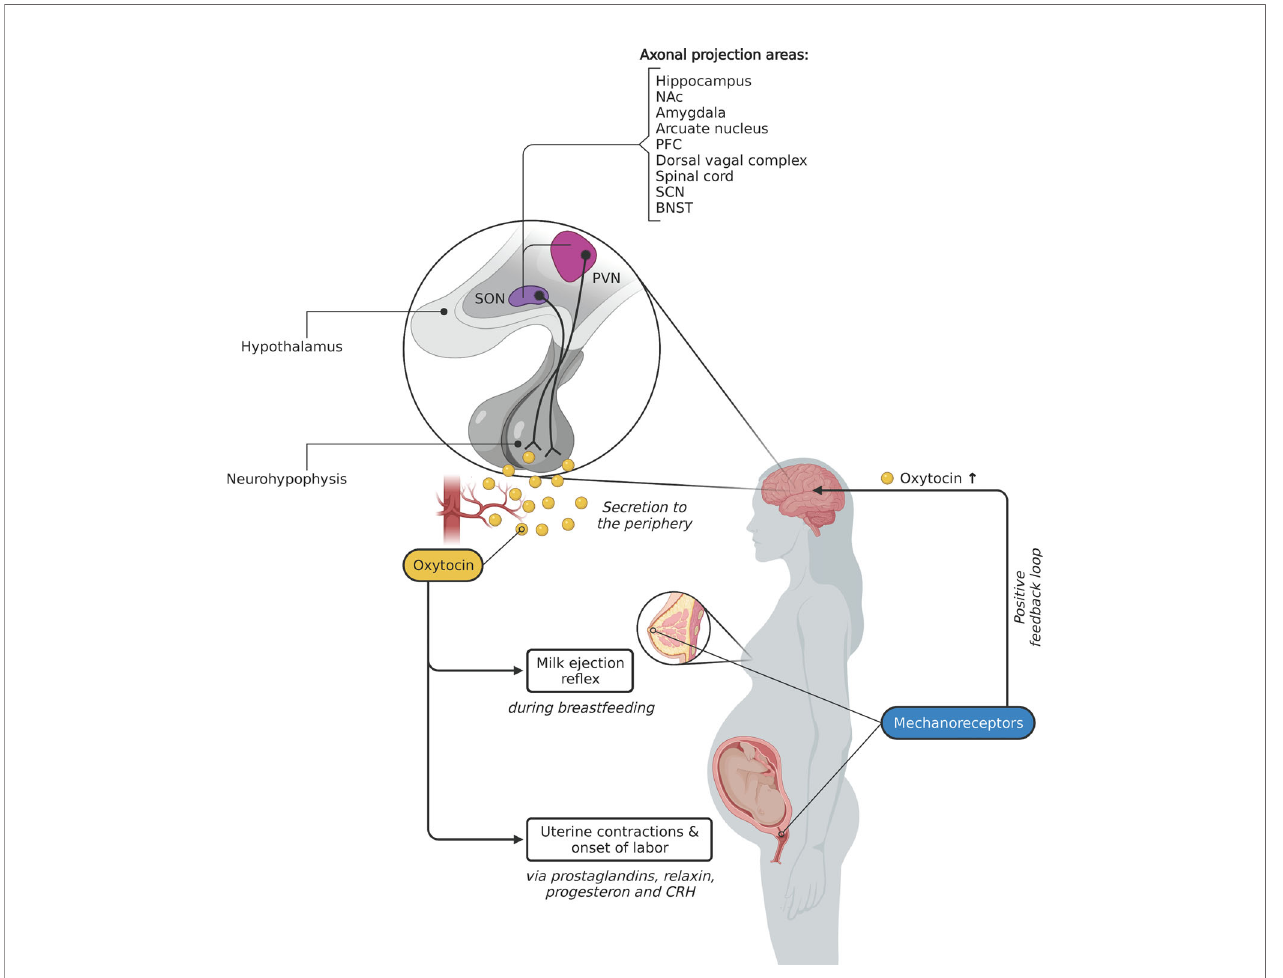
FIGURE 1 | Peripheral effects of central oxytocin release during childbirth and lactation. The neuropeptide oxytocin is mainly produced by magnocellular neurons in the paraventricular nucleus (PVN) and the supraoptic nucleus (SON) of the hypothalamus. Axons of these neurons terminate in the neurohypophysis, where oxytocin is secreted – in pulses – into the blood. Mechanoreceptors in the nipple (activated by the suckling newborn) and the cervix (cf. Ferguson re fl ex) create a positive sensory feedback loop, which leads to the additional release of oxytocin in the brain. Oxytocinergic neurons in the hypothalamus also release oxytocin to other brain areas (sources: 7 – 9) via axonal transport and via dendritic release (not shown). NAc, Nucleus accumbens; PFC, Prefrontal cortex; SCN, Suprachiasmatic nucleus; BNST, Bed nucleus of the stria terminalis. Created with